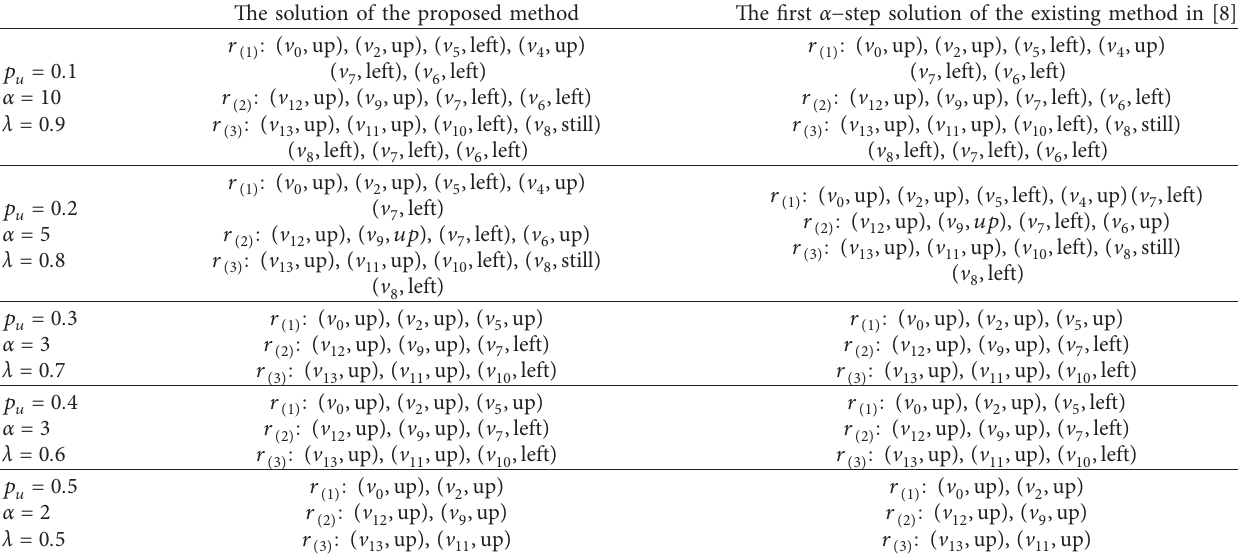
Table 1: The solution of path planning for three robots which are in different locations as shown in Figure 7. The solution of the proposed method The first α − step solution of the existing method in